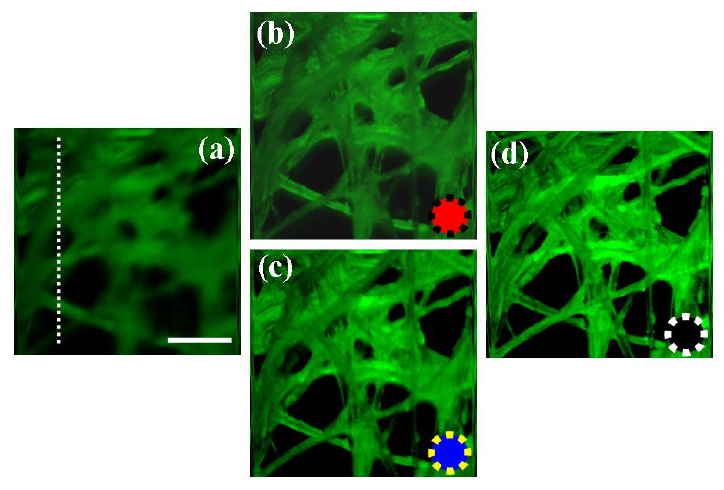
Figure 5. TPEF images of the cellulose sample (100 μ m depth) recorded before ( a ) and after using the optimum values of SA ( b ), axicon ( c ), and pair SA–axicon ( d ). Bar length: 50 μ m.